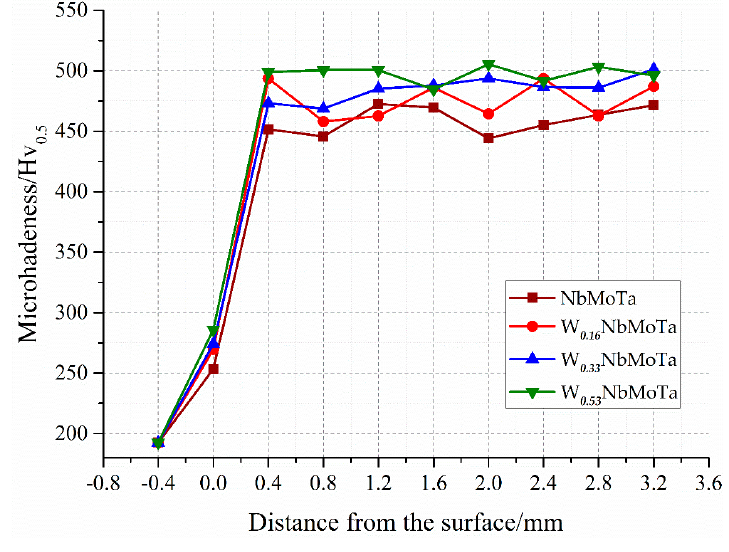
Figure 10. Microhardness of the W x NbMoTa HEAs fabricated in LCD. Table 5. Experimental H v and theoretical H v values of the W x NbMoTa HEAs.